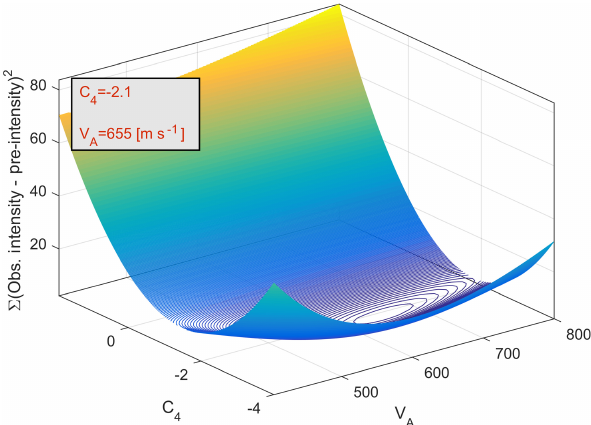
Figure 12. A sensitivity analysis for calibration of the new